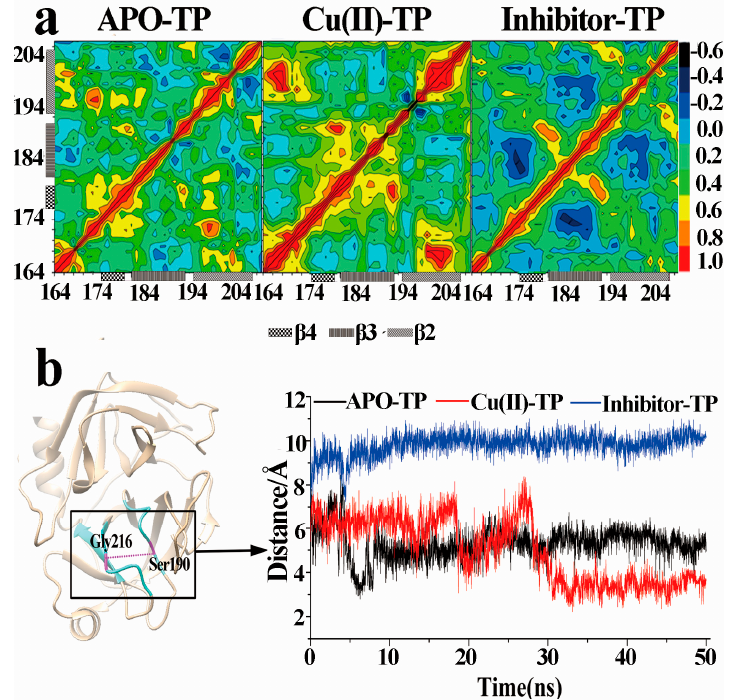
Figure 8. Dynamical cross ‐ correlation maps and distance fluctuation plot. ( a ) Dynamical cross ‐ correlation maps (DCCM) of S1 pocket residues for the APO ‐ TP, Cu(II) ‐ TP and inhibitor ‐ TP models. The correlation efficient between two residues is represented by the color map shown on the right side. Blue represents the strong anticorrelated motions and red represents the strong correlated motions; ( b ) The distance fluctuation plot between C α atoms of Ser190 and Gly216 for the three systems as a function of simulation time. The distance measures the open degree of S1 pocket in the trypsin. The S1 pocket is colored cyan and the two residues are colored magenta.